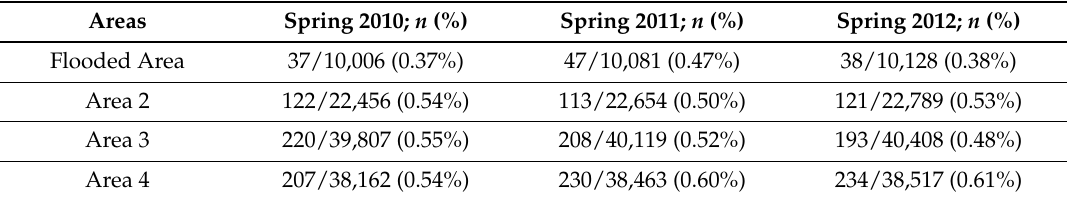
Table 2. Occurrence of acute CVD during springs 2010 to 2012, and according to the different study areas. Areas